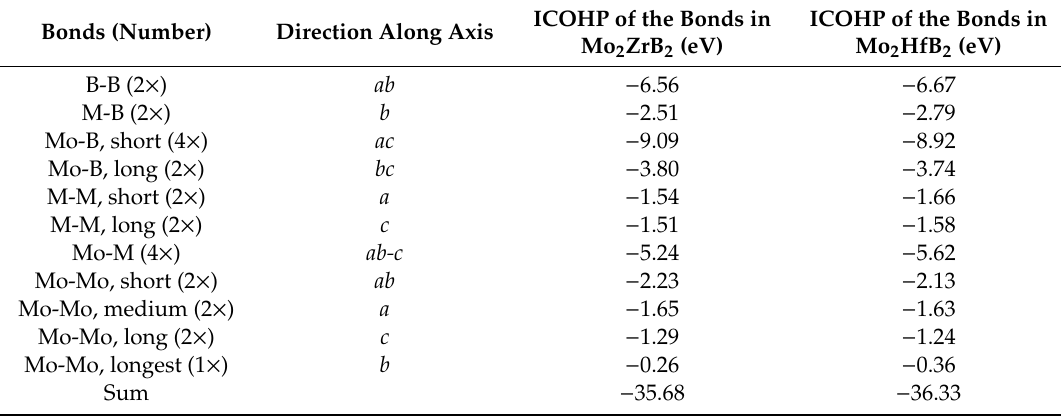
Table 4. Integrated crystal orbital Hamilton population (ICOHPs) per formula unit of the